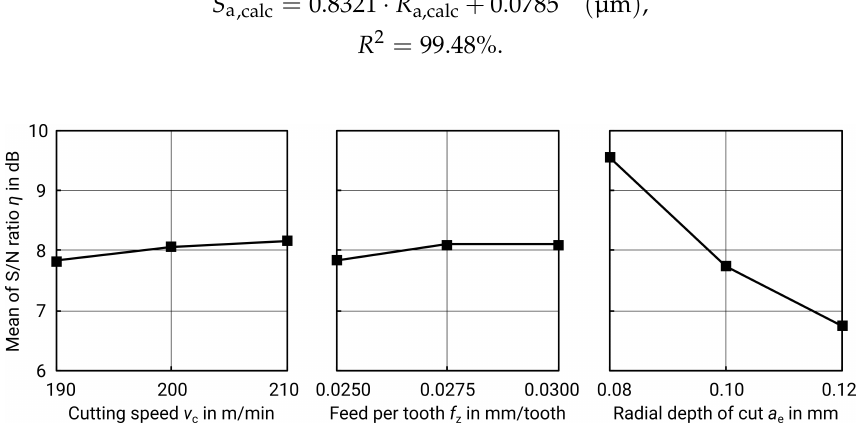
Figure 10. Main effect plot for S/N ratios for S a of milled vertical surfaces.